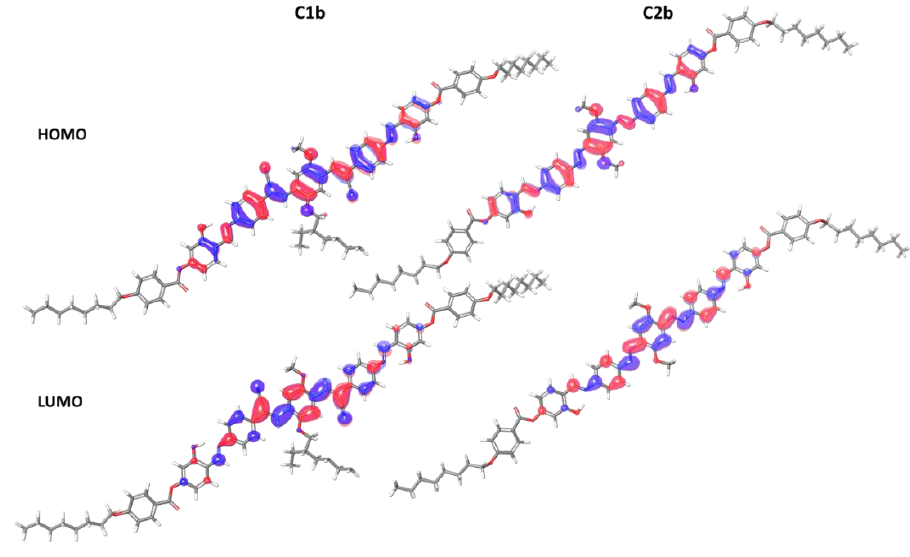
Table 3. Electro-optical properties calculated on C1b and C2b.